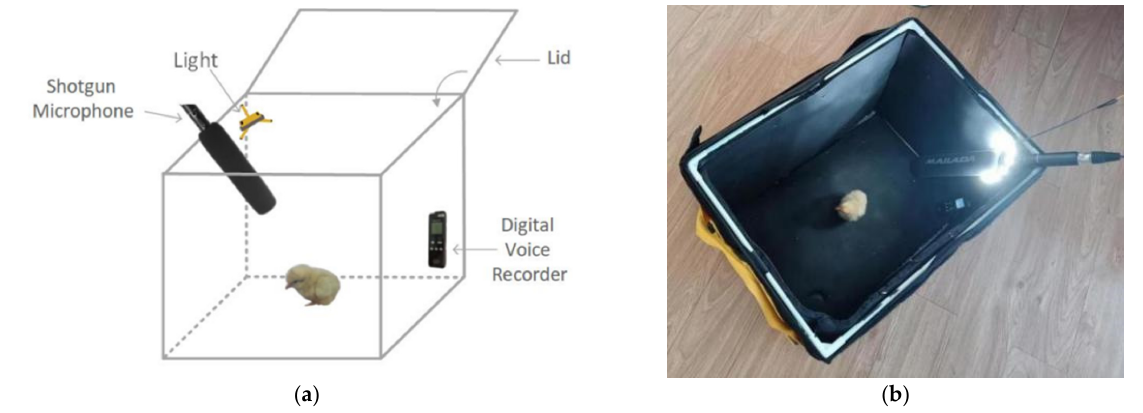
Figure 2. Data collection system: ( a ) diagram; and ( b ) entity.